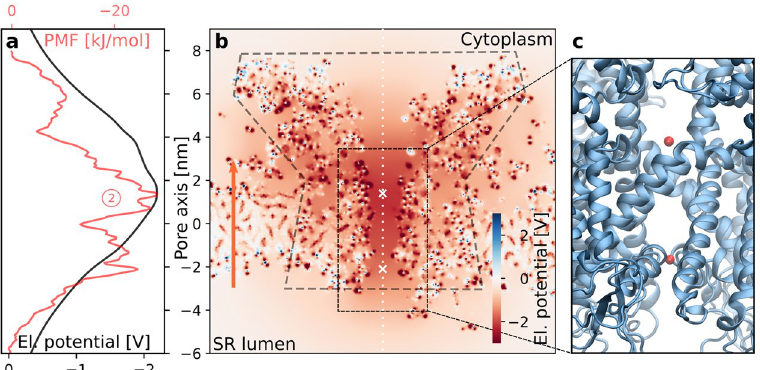
Figure 3. ( a ) One-dimensional electrostatic potential along the channel axis (white dotted line in panel ( b )). The PMF for calcium is shown in red to aid orientation. ( b ) The two-dimensional electrostatic potential on a slice across RyR1. Dashed lines mark the outline of the channel to aid orientation. The locations of the two main PMF basis are marked by white crosses. The orange arrow indicates the direction of the calcium current. ( c ) Two red spheres were placed in the main PMF basins.